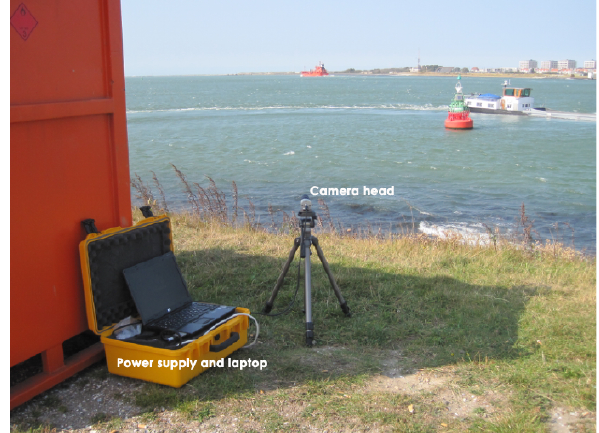
FIGURE3. PhotographoftheUVcameramountedonatripodwithlaptopandcamerabox. Fig. 3. Photograph of the UV camera mounted on a tripod with laptop and camera